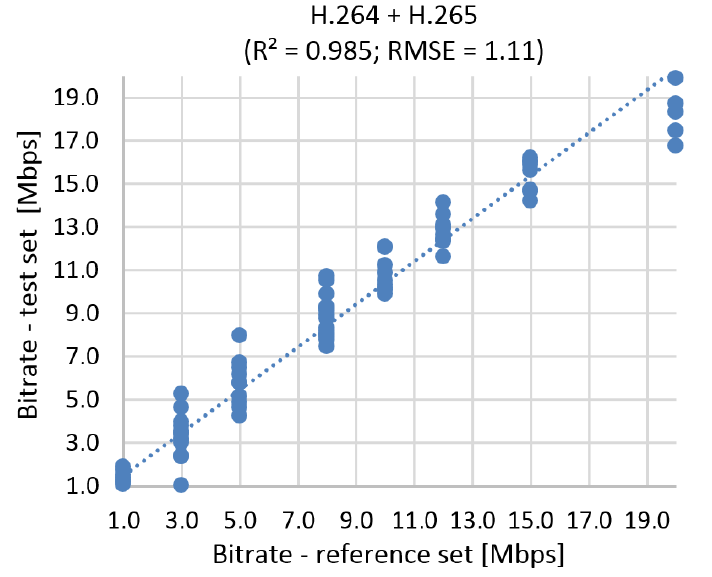
Figure 22. Correlation diagram for bitrate prediction based on SSIM, Full HD + Ultra HD , H.264 +